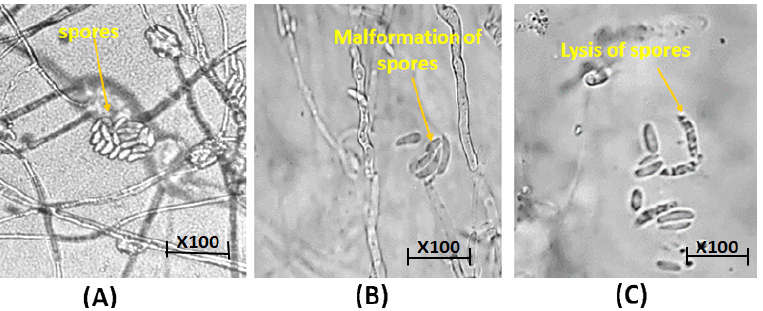
Figure 5. Light microscope observation of spores of F. solani showing ( A ): untreated control with normal spores and mycelium (yellow arrows). ( B ): Treated with Cu 2 ONPs (0.35M), showing collapsed spores (yellow arrows) and ( C ): treated with Cu 2 ONPs (0.30M), showing collapsed spores (yellow arrows).